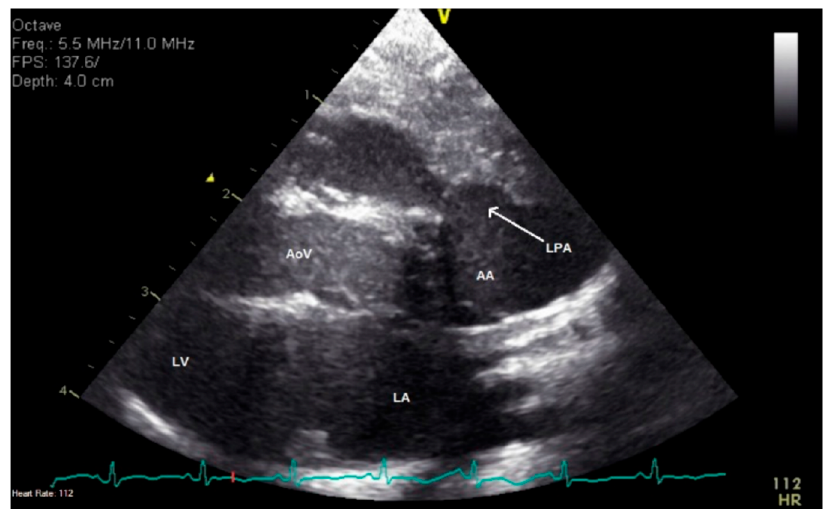
Figure 1. Two-dimensional echocardiography in the parasternal long-axis view. The aorta is seen arising from the left ventricle and there is a structure arising from the anterior aspect of the ascending aorta. This was confirmed by additional imaging to be the left pulmonary artery.